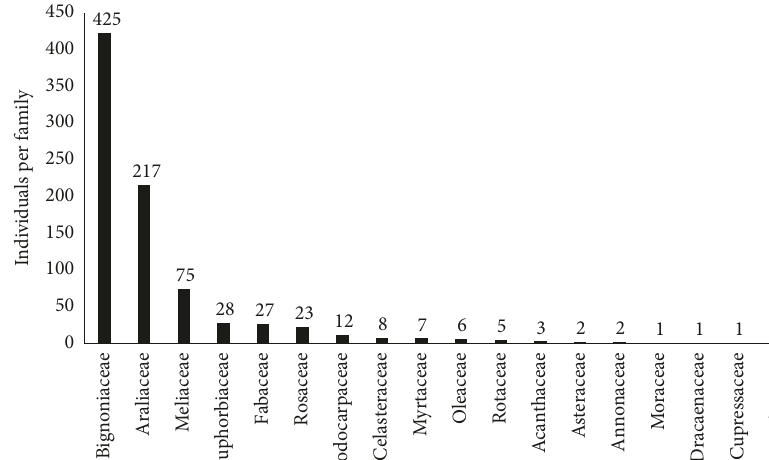
Figure 4: Number of individual trees and shrubs occurring in respective families in the self-regenerated secondary forest in Ruhande Arboretum, Huye, Rwanda.